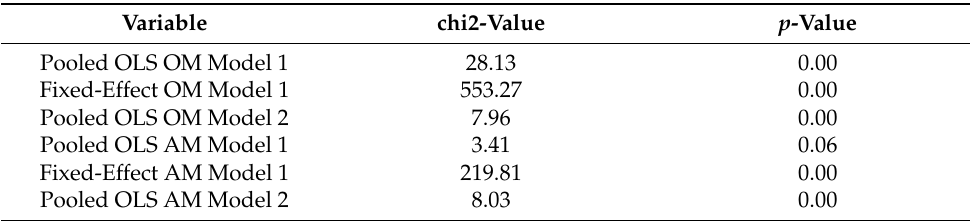
Table A3. Breusch-Pagan (LM) test for heteroscedasticity.